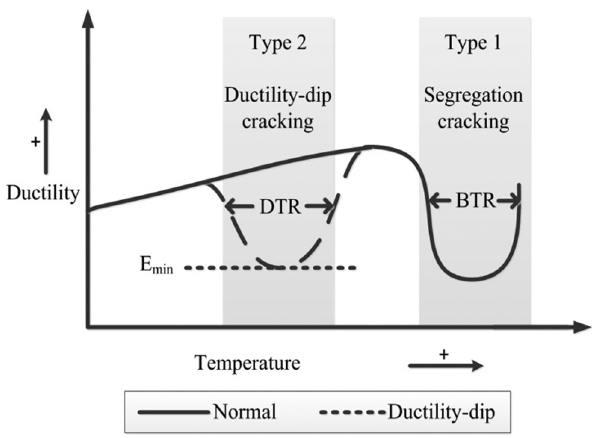
Figure 7: Schematic diagram of ductility as a function of